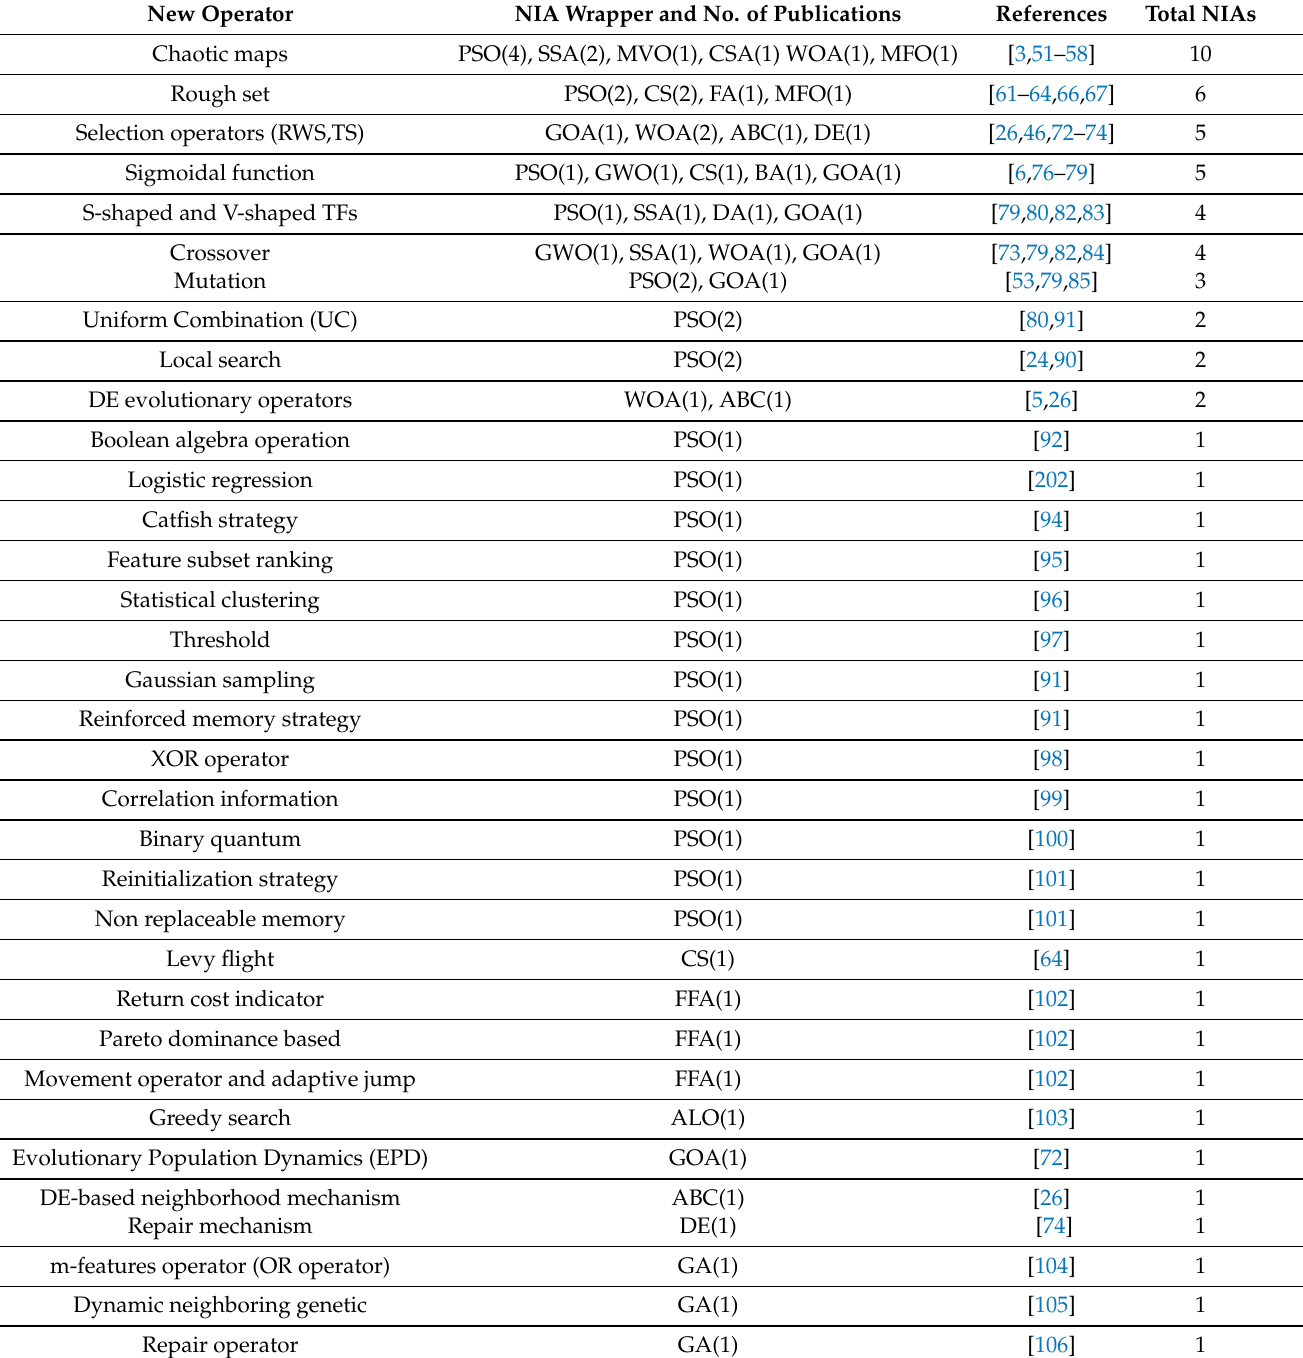
Table 1. Summary of main ro pub the tables, and please check if it is the background color can be deleted, same as follows. studies in the literature that adopted new operators as modification techniques for Nature Inspired Algorithms Feature Selection